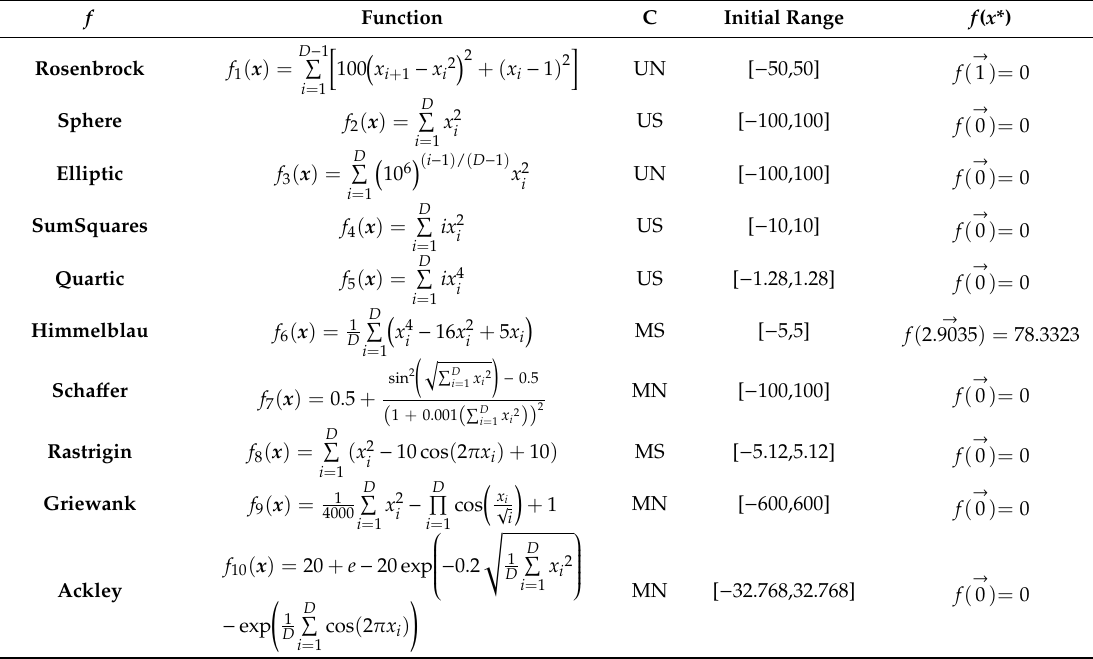
Table 2. The 10 benchmark functions for experimental